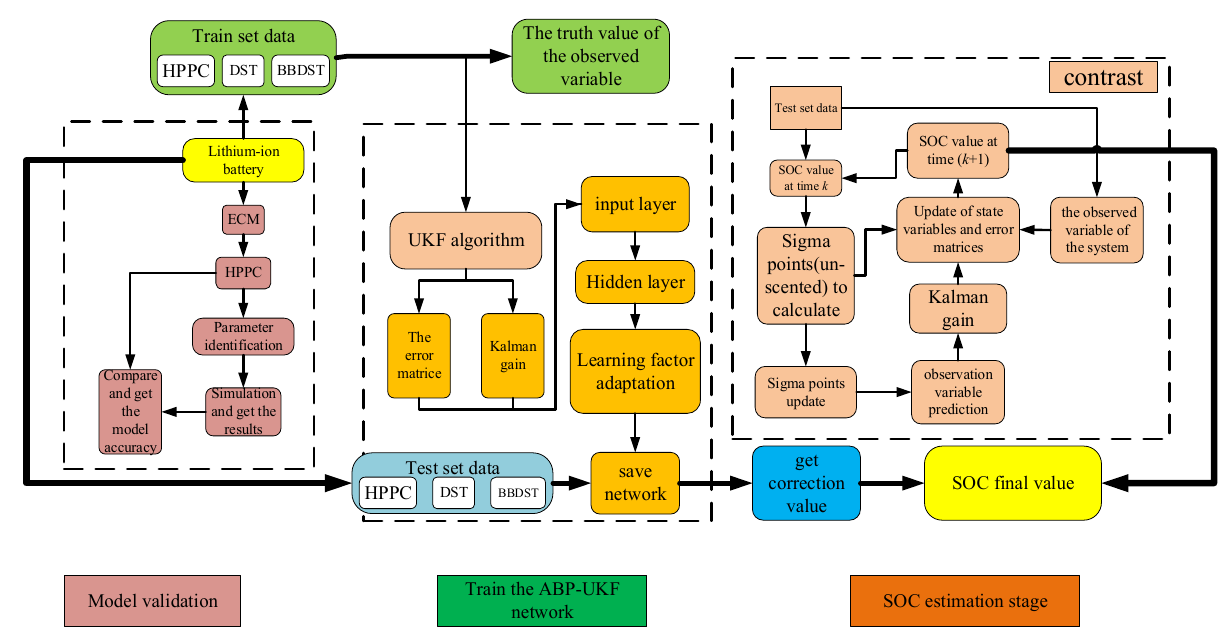
Figure 5. Lithium-ion battery state of charge estimation model.